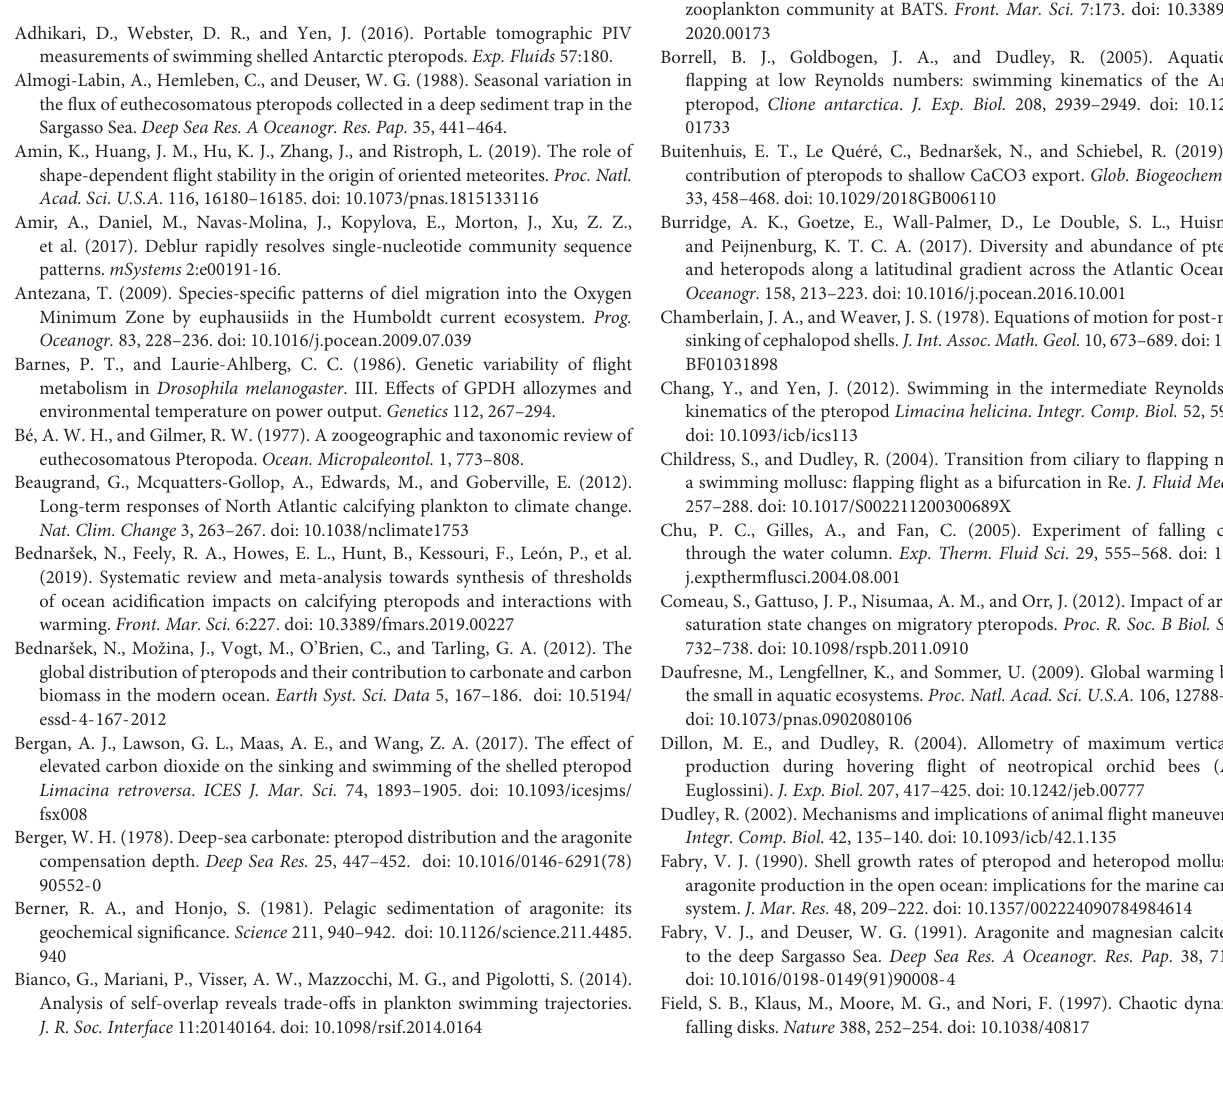
FIGURE S3 | Box plots of glide angle and swimming NGDR results for three different shell shape groups. (A) Glide angle. (B) NGDR. Groups which do not share a letter are statistically different from each other ( p < 0.05) as determined by a one way ANOVA test and Tukey-Kramer pairwise comparisons. Outliers are demarcated as a plus sign ( + ). FIGURE S4 | Vertical distributions based on image data and molecular data. (A) Day and Night vertical distribution based on the relative proportion of the population within a particular size bin (mm). (B) Average day and night biomass profiles based on imaging. (C) Average day and night biomass profiles based on molecular barcoding. TABLE S1 | Tukey-Kramer pairwise comparison test between the three pteropod shell shape groups. C – coiled shell, E – elongated shell, G – globular shell groups. Bold values show P < 0.05. FILE S1 | MOCNESS net sampling